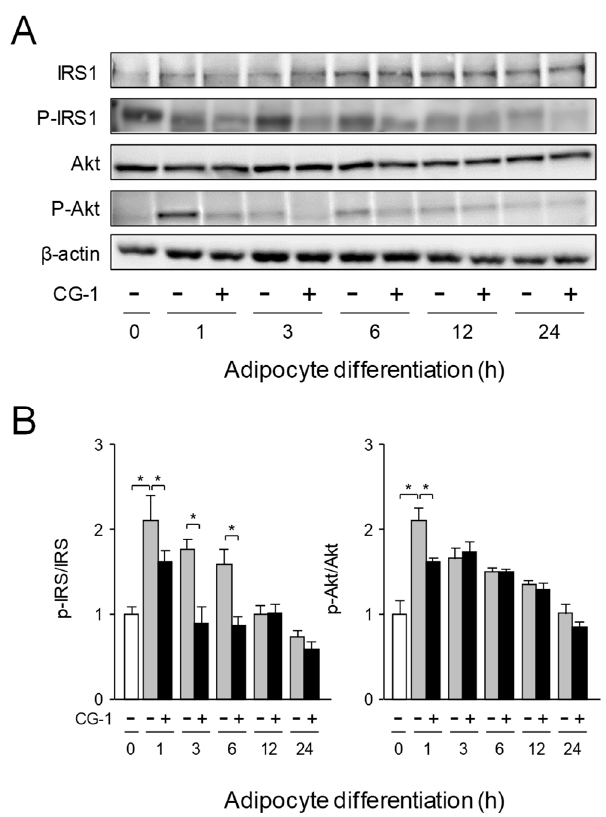
Figure 5. Inhibition of activation of IRS-1/Akt axis by CG-1. ( A ) Expression and phosphorylation of IRS-1, and Akt in CG-1-treated 3T3-L1 cells. The cells were differentiated into adipocytes for the indicated time in DMEM with CG-1 (0 or 10 μ M). Proteins (15 μ g/lane) were subjected to SDS-PAGE-Western blot analysis. Data are representative of three experiments. ( B ) Band intensity of Western blot analysis. Results are presented as the means ± S.D. * p < 0.01, as indicated by the brackets.